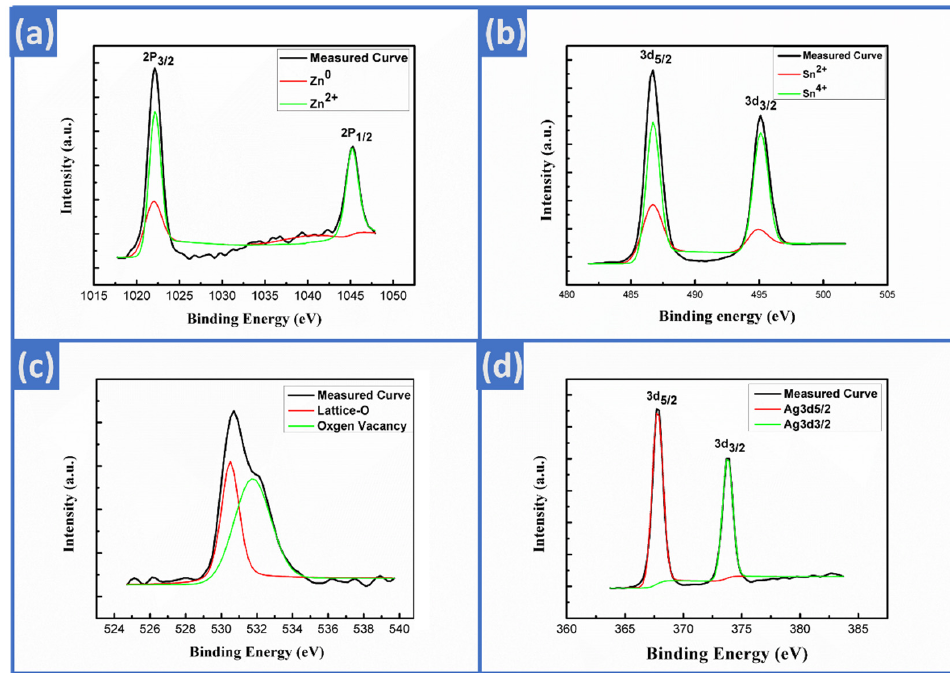
Figure 3. XPS analysis for Ag-ZTO NWs. ( a ) Zn 2p, ( b ) Sn 3d, ( c ) O 1s, ( d ) Ag 3d.